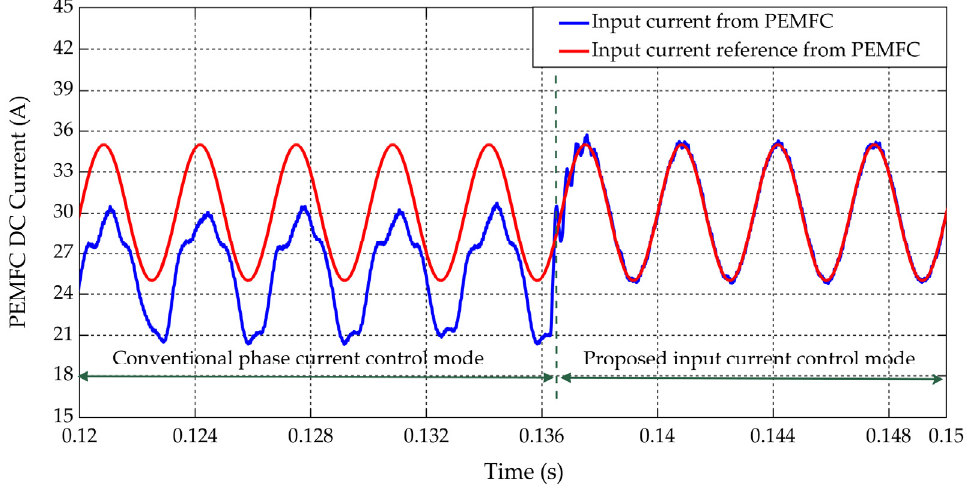
Figure 11. Shaping of the PEMFC current under the conventional phase current control and the proposed input current control.